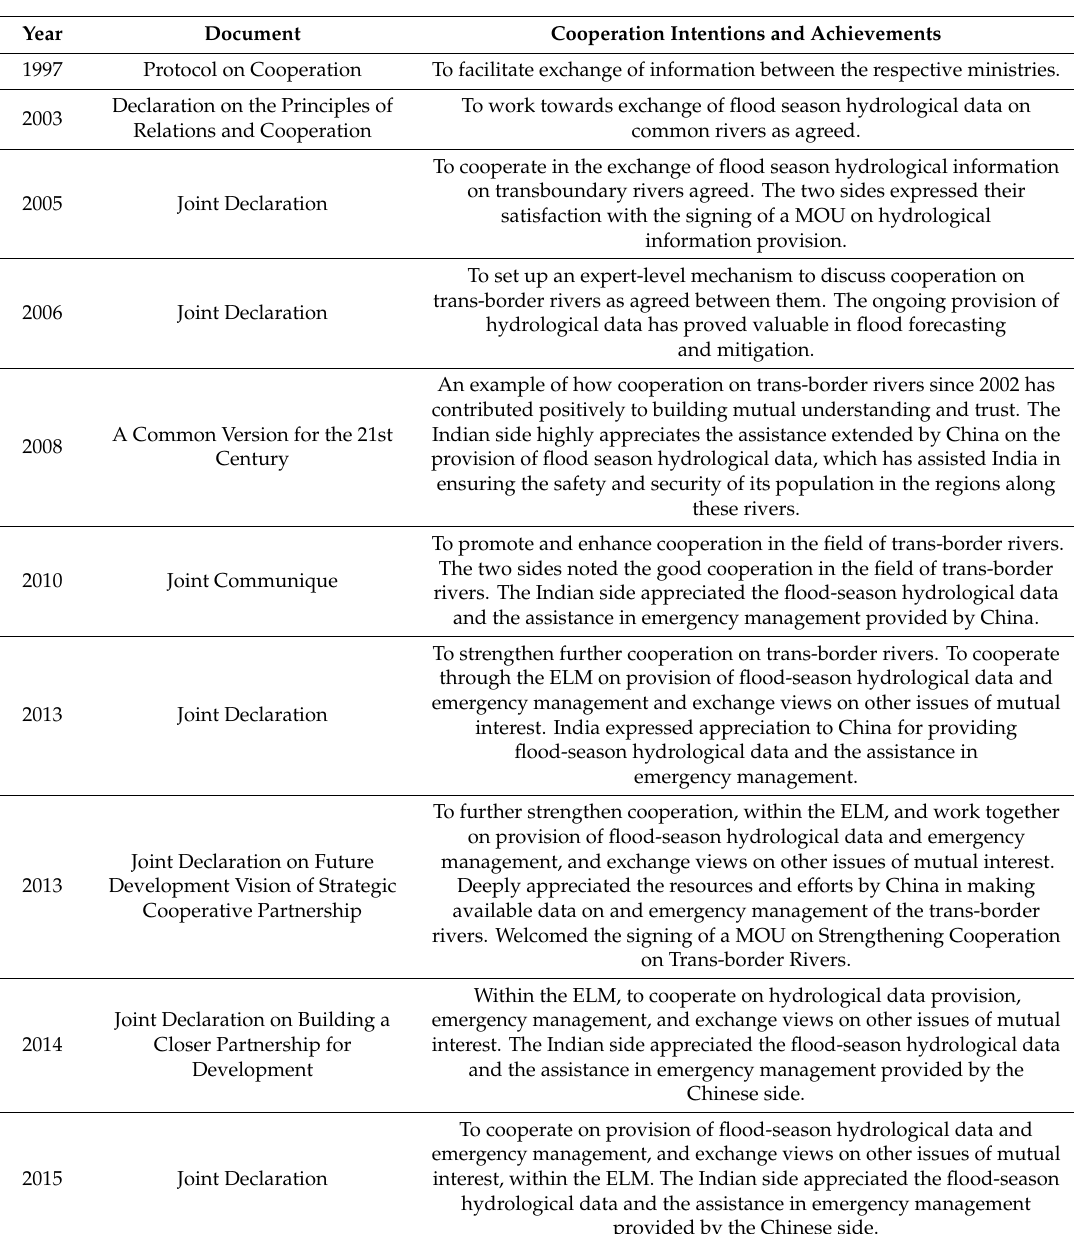
Table 3. Issues in cooperation on transboundary rivers in the bilateral o ffi cial